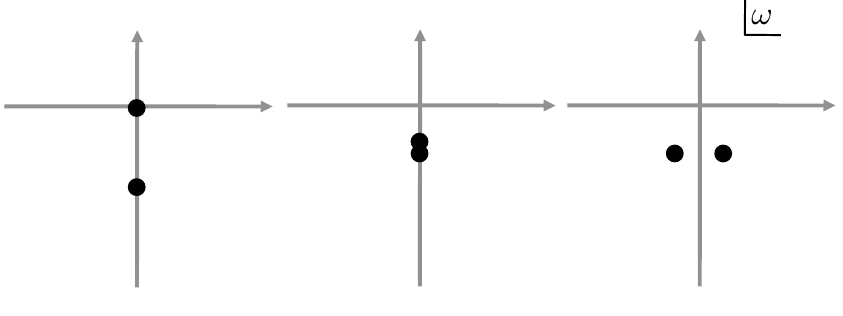
Figure 1: Cartoon illustration of movement of diffusion and plasma oscillation pole in complex frequency ≈ 0.037 and then move off plane as k is increased from left to right; poles collide on imaginary axis at k (cid:63) 2 π T of axis